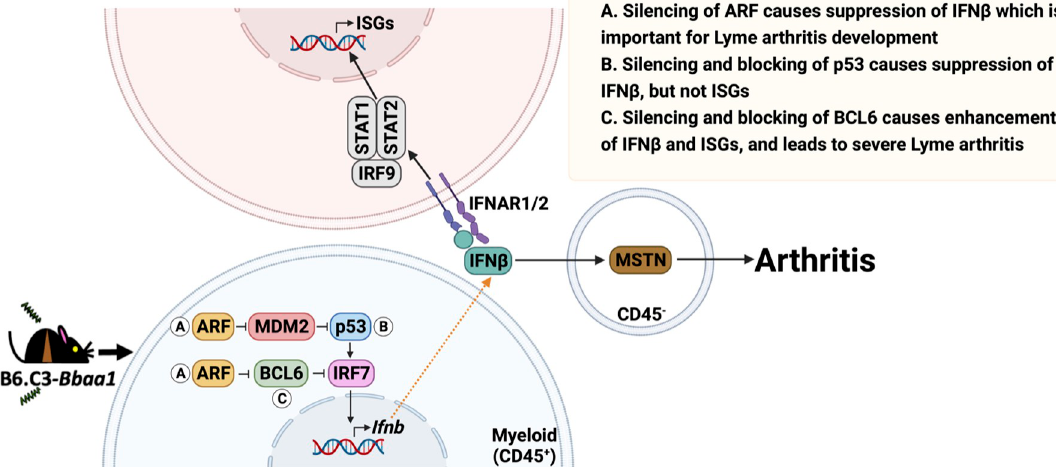
Fig 10. Proposed model of ARF-IFN β pathway. A) The constitutively heightened expression of ARF in B6.C3- Bbaa1 congenic mice results in a greater magnitude of IFN β production and more severe Lyme arthritis following infection with B . burgdorferi . B) The heightened expression of the C3H allele of ARF blocks the activity of ubiquitin ligase MDM2, resulting in stabilized p53. p53 acts to enhance the expression of IRF7 which induces IFN β production, but not downstream ISGs. C) The greater expression of the C3H allele of ARF also binds and suppresses BCL6, resulting in increased IRF7 expression and greater production of IFN β . Expression of downstream ISGs is mediated through activation of signal transducer and activator transcription 1 (STAT1)-STAT2-IRF9 signaling complex. Parallel ARF interactions with p53 and BCL6 modulate IFN β hyper production in resident myeloid cells. IFN β leads to the upregulation of the muscle regulatory protein myostatin in CD45 - cells, a previously identified mediator of Lyme arthritis development in B6.C3- Bbaa1 mice. (Created with